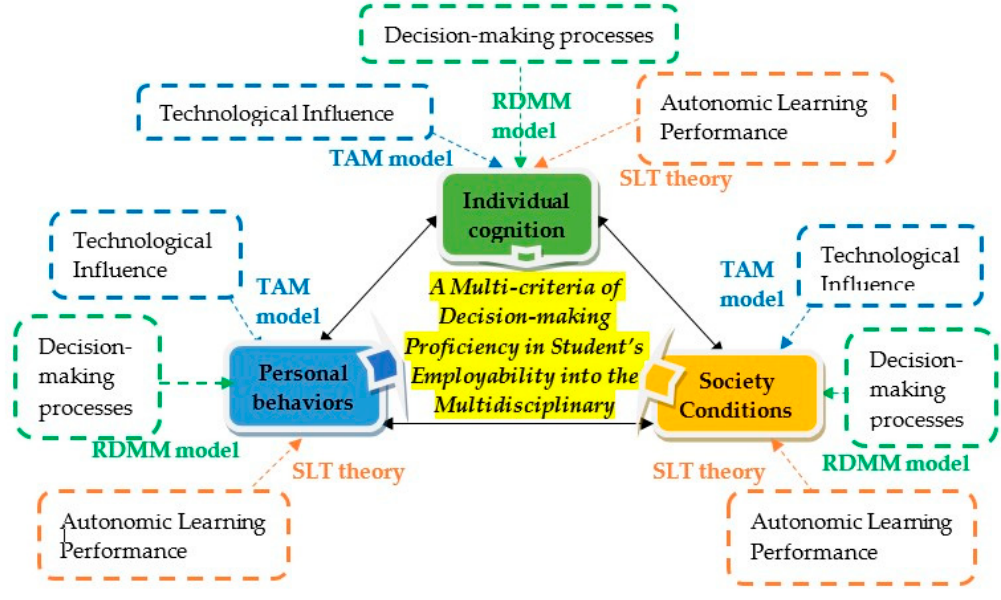
Figure 1. The three most important analytical perspectives.